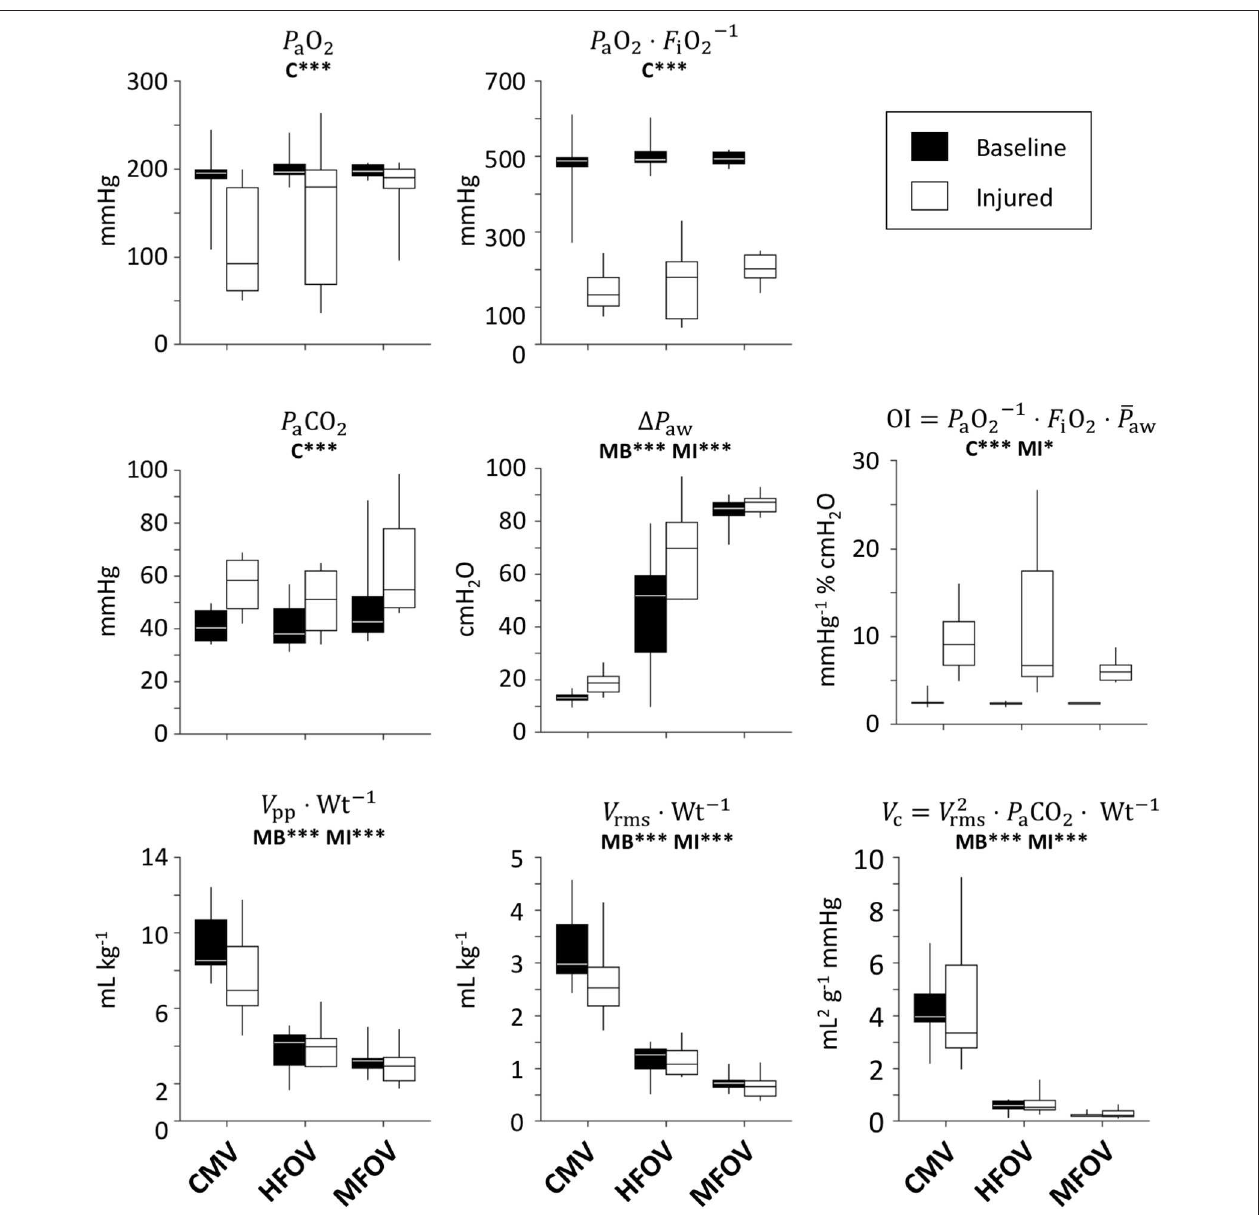
FIGURE 5 | Gas exchange outcomes, represented by box plots showing minimum, maximum, and quartiles across subjects under baseline (black) and injured (white) conditions, during conventional mechanical ventilation (CMV), high-frequency oscillatory ventilation (HFOV), and multi-frequency oscillatory ventilation (MFOV). Asterisks indicate significance levels (* p < 0.05, *** p < 0.001) for main effects (C condition). See Table 2 for additional clarification. P a O 2 airway pressure amplitude; V pp